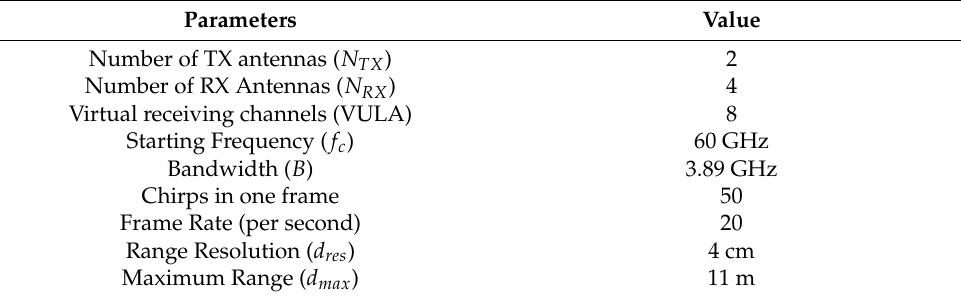
Table 1. Parameters of OTS radar used in this study.